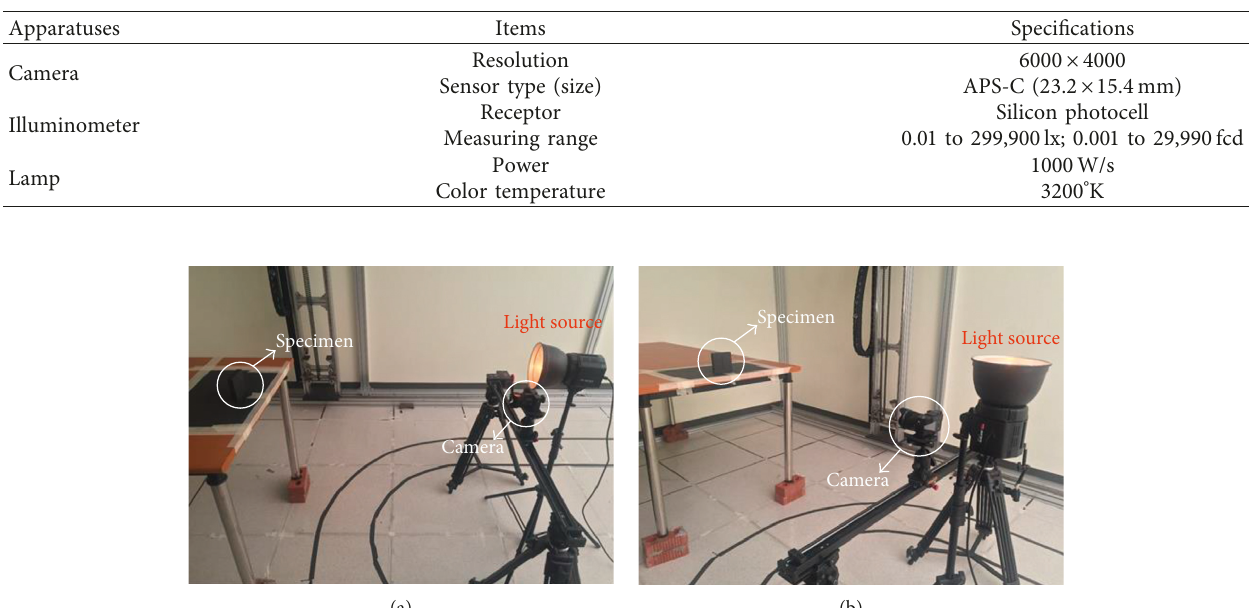
Figure 4: Test specimens painted with black matte spray and contrast index attached to the center of the Table 1: Equipment specifications.